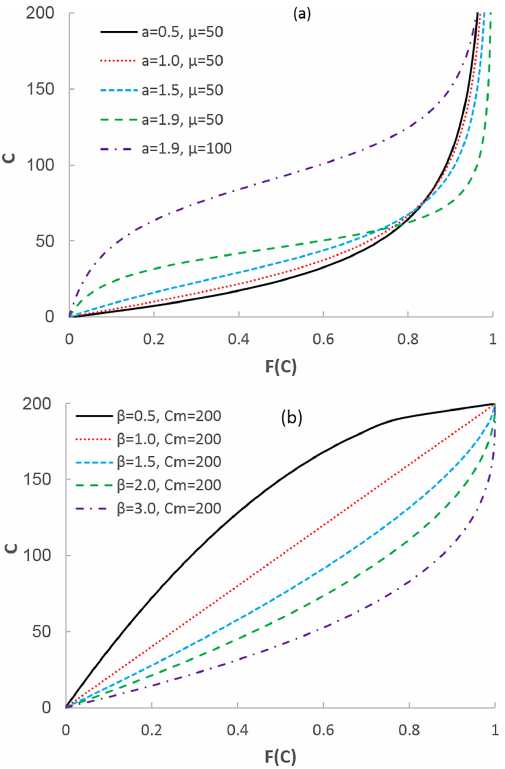
Figure 3. The probability density functions (PDFs) with different parameter values: (a) the proposed PDF represented by Eq. (24) and (b) the generalized Pareto distribution of the VIC model, i.e., Eq. (25).